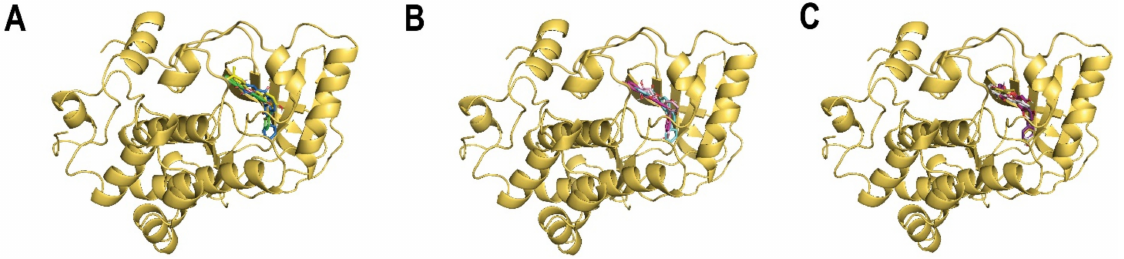
Figure 3. Molecular docking of top 10 selected flavonoids to MEK2. The proteins shown in cartoon representation are colored yellow-orange, while compounds are shown in stick representations. ( A ) Binding of flavonoids ‘M2F1’ (blue), ‘M2F2’ (green), and ‘M2F3’ (yellow). ( B ) Binding of flavonoids ‘M2F4’ (pink), ‘M2F5’ (light-pink) and ‘M2F6’ (cyan). ( C ) Binding of flavonoids ‘M2F7’ (violet), ‘M2F8’ (white), ‘M2F9’ (magenta) and ‘M2F10’